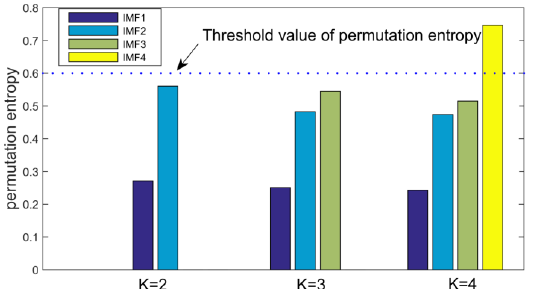
Figure 4. Permutation entropy of Intrinsic Mode Functions (IMF) in each iteration of PEO algorithm with different K value in the VMD.